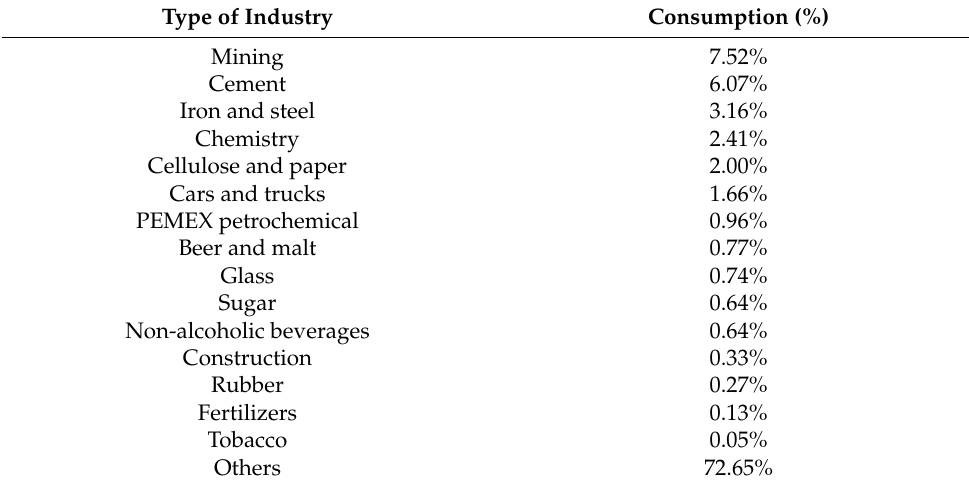
Table 3. Electrical energy consumption in the Industrial Sector, Mexico, 2019. Type of Industry Consumption (%)